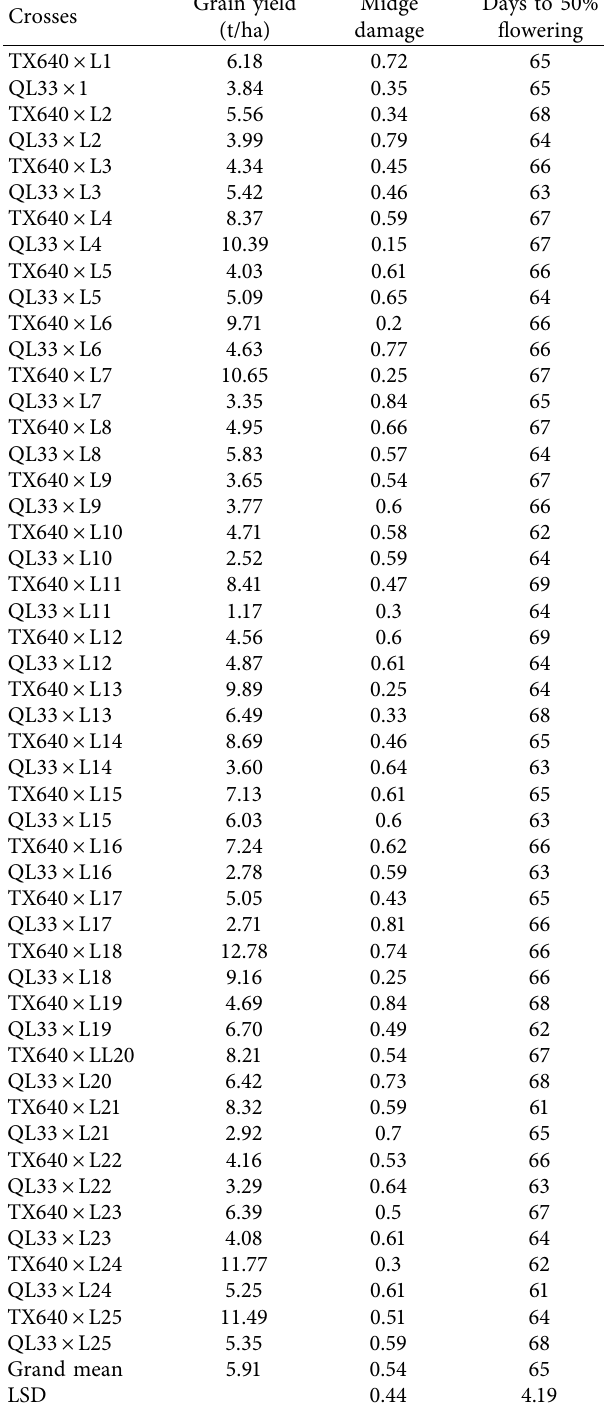
Table 1: Mean squares for traits of 50 experimental hybrids evaluated in the 2015 rainy season.